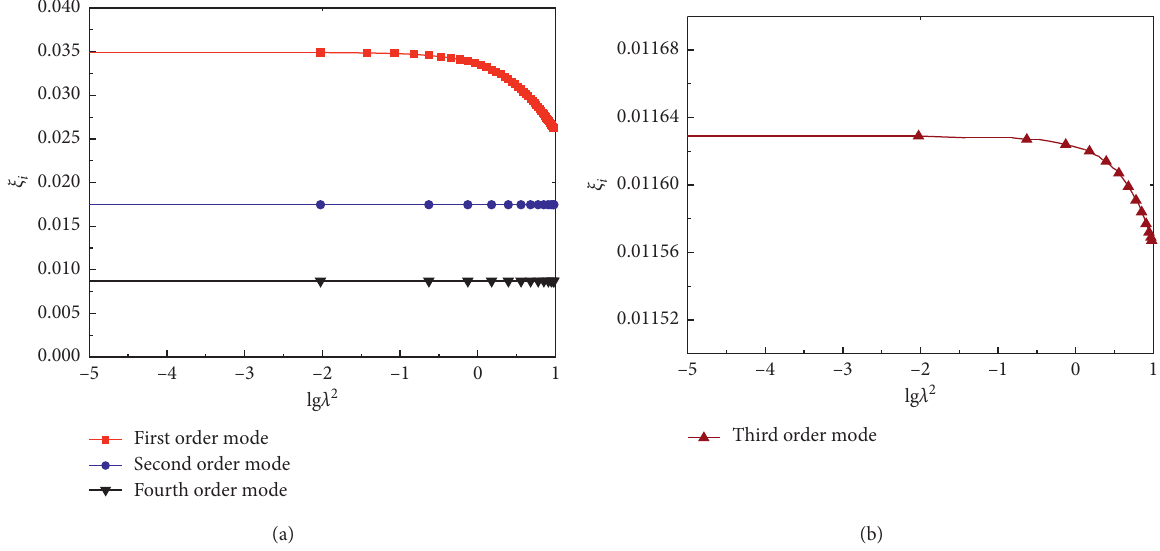
Figure 6: Relationship between in-plane modal damping ratios and sag of tether.